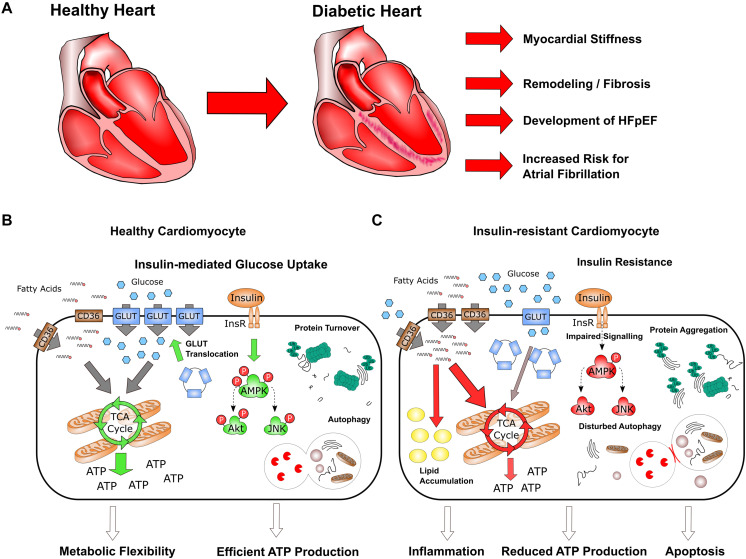
Characteristics of heart failure in diabetes. (A) Long-time diabetes is associated with structural remodeling, fibrosis and increased myocardial stiffness in the heart, which lead to the development of HFpEF as well as increased risk for atrial fibrillation. (B,C) On the cellular level, insulin-mediated glucose uptake in healthy cardiomyocytes is of key importance for metabolic flexibility and efficient ATP production (B); insulin resistance strongly impairs metabolism and homeostasis in cardiomyocytes, resulting in reduced ATP production and increased inflammation and apoptosis (C).